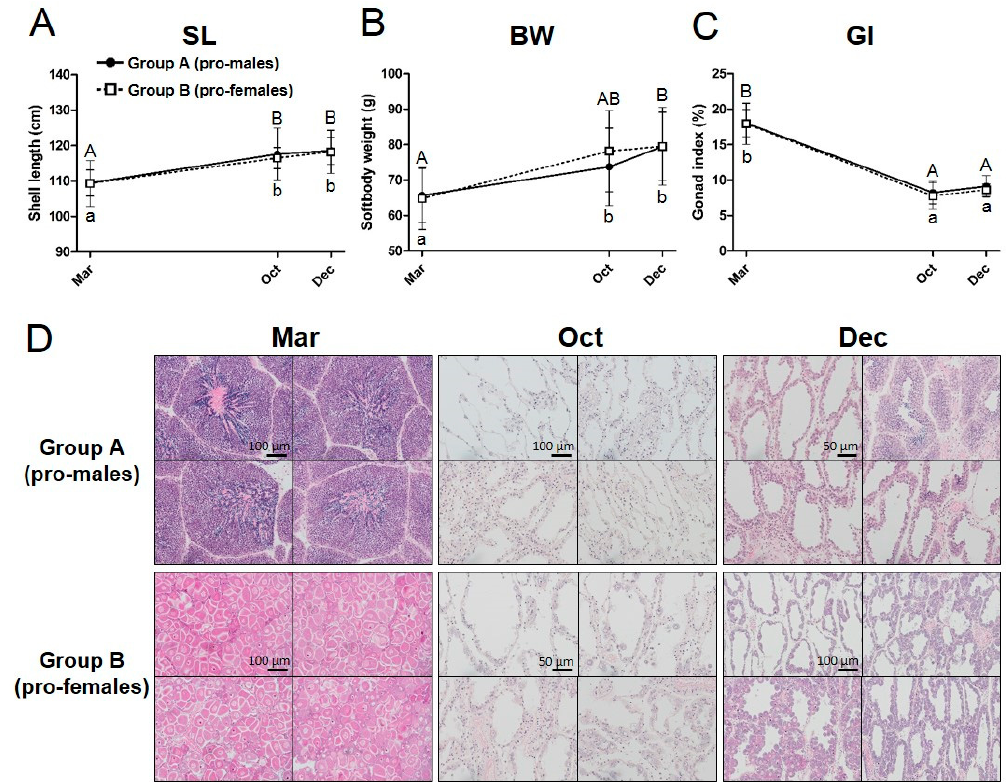
Figure 2. Growth and reproductive histories of the two-year-old Yesso scallops during the tracking experiment. Details of the body growth are shown for ( A ) shell length (SL), ( B ) softbody weight (BW), and ( C ) gonad index (GI). Lines with dots and dashed line with boxes show the data of group A (pro-males) and group B (pro-females) populations, respectively. Error bars show SEM at each sampling point ( n = 10 for each group). Di ff erent superscript letters indicate significant di ff erences within sex (lower case for pro-females and upper case for pro-males). ( D ) Representative histological observations for both groups are shown at each sampling point. Hematoxylin and eosin (HE) staining was performed for the gonads of pro-males and pro-females at di ff erent stages. March (Mar): Group A (pro-males) have mature testes. Testes are mainly filled with meiotic germ cells (e.g., spermatocytes and spermatids). Sperm are found in the center area of germinal acini. Group B (pro-females) have ovaries filled with full grown oocytes. October (Oct): Both group A (pro-males) and group B (pro-females) possess a small number of spermatogonia and oogonia, respectively. A few primary oocytes are observed in germinal acini of group B (pro-females) distinguishing it from group A (pro-males). December (Dec): Group A (pro-males) mainly possess proliferating spermatogonia, while group B (pro-females) possess growing oocytes.